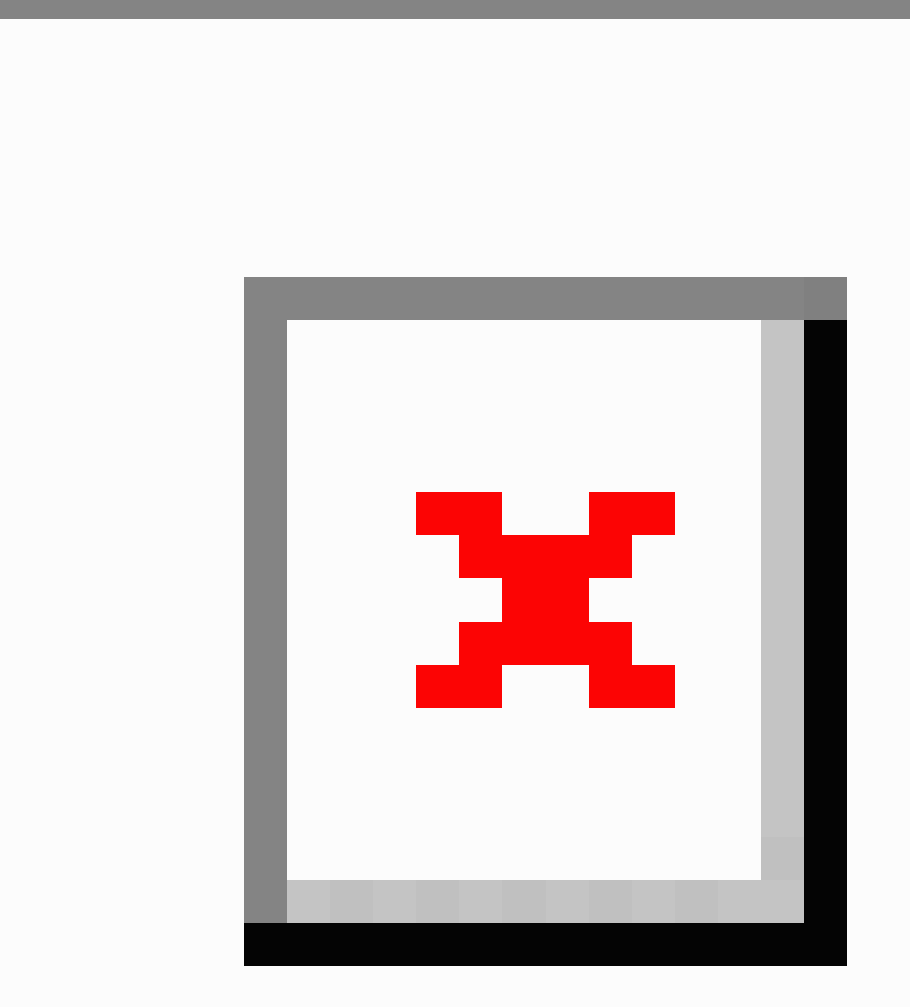
Figure 1. Patient flow diagram. *Two patients later died. **One patient later